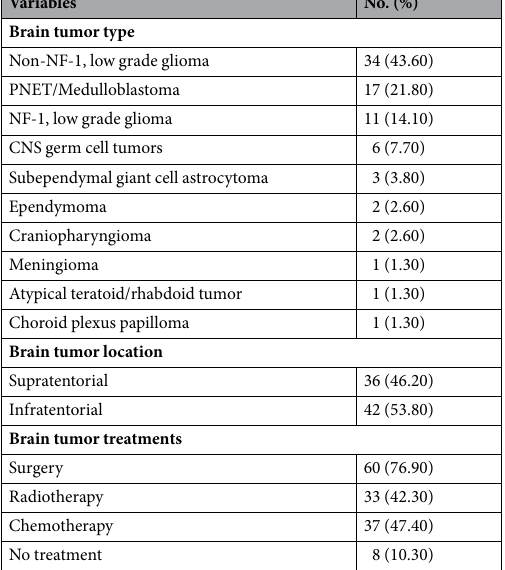
Table 2. Brain tumor type, location, and treatments (n = 78). Abbreviations: CNS, Central Nervous System;